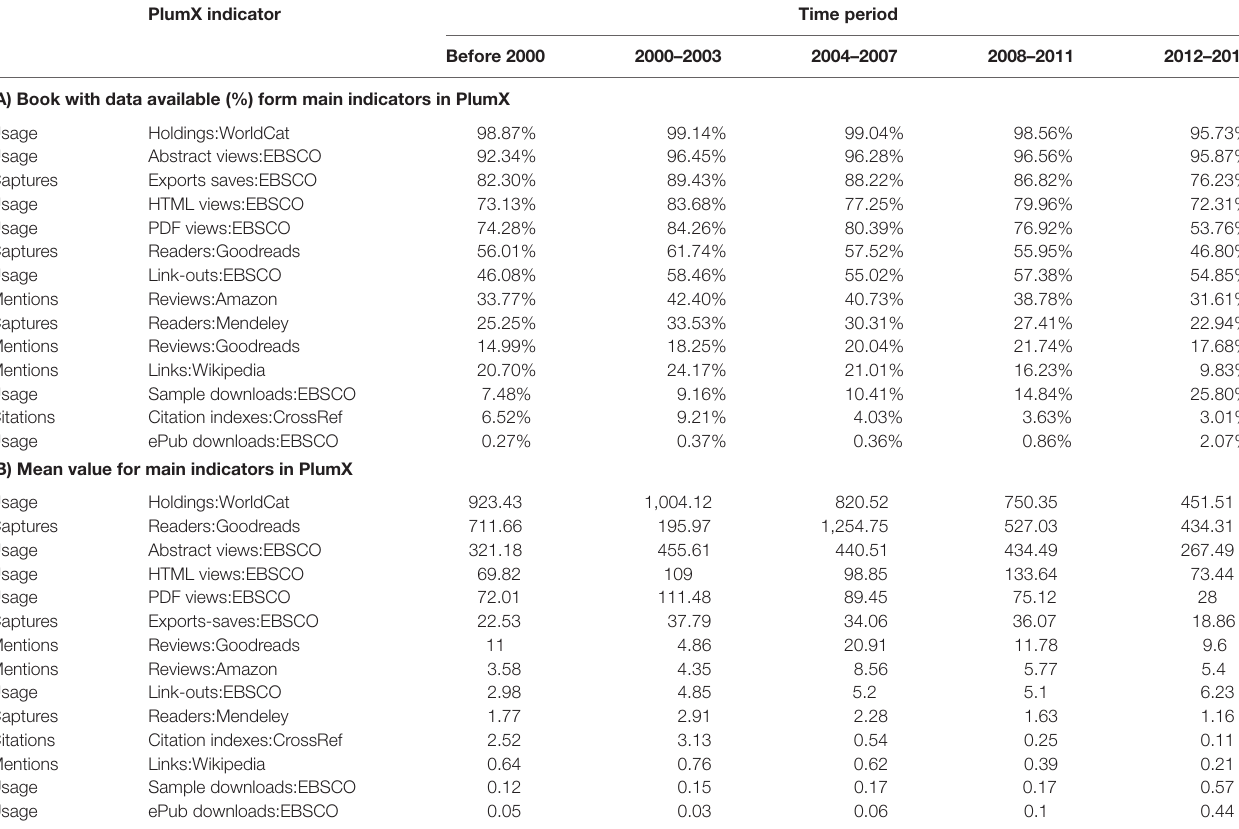
TaBle 4 | Percentage of availability and mean value for main measures and tool over the time. PlumX